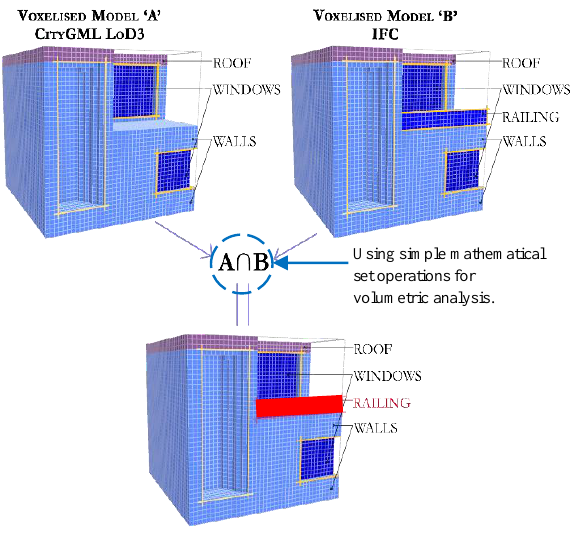
Figure 2 Conceptual approach to the 3D intersection of two voxel models. (The red voxels in the railing highlight the